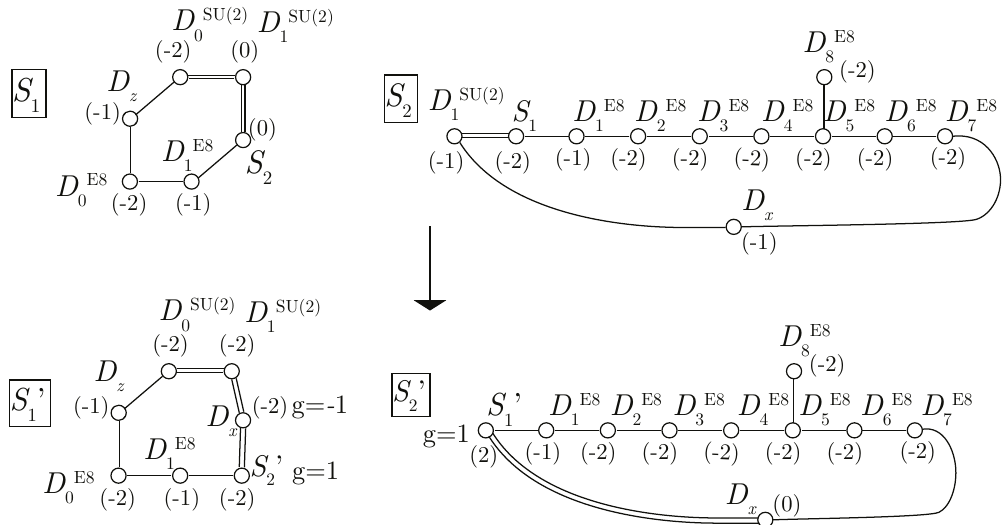
Figure 3. The (cid:13)op operation on the resolution geometry of ( E 8 ; SU(2)) conformal matter (rank- two E-string). On each surface component S i (labeled by the letter in the box), each node D (cid:11) corresponds to the intersection curve S i (cid:1) D (cid:11) . The number besides the node is the intersection number ( D (cid:11) ) 2 (cid:1) S i . The genus of such a curve is by default zero unless otherwise labeled. In this geometry, the intersection curve S 1 (cid:1) S 2 has genus-zero. After the (cid:13)op, the intersection curve S 0 has